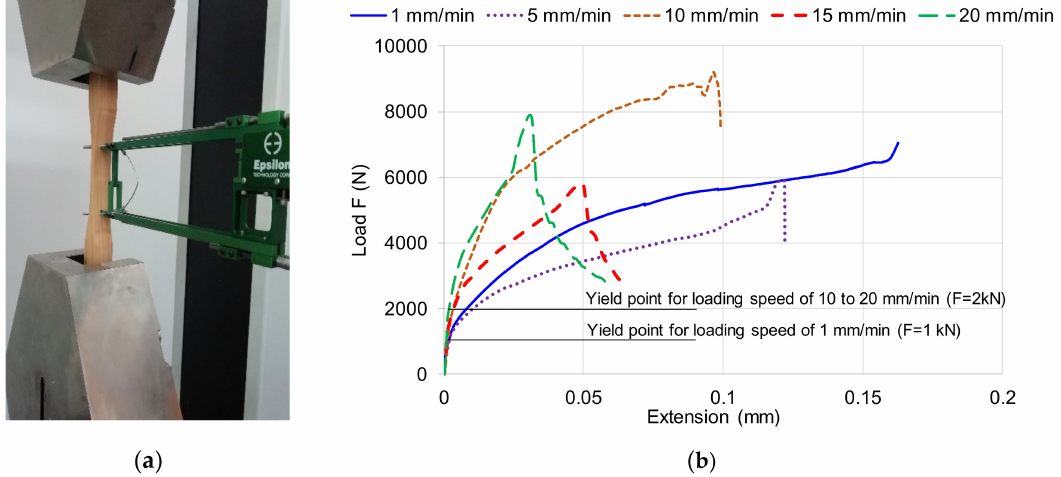
Figure 1. The preliminary test: ( a ) tensile test; ( b ) characteristic curves of pine wood subjected to tensile with di ff erent loading